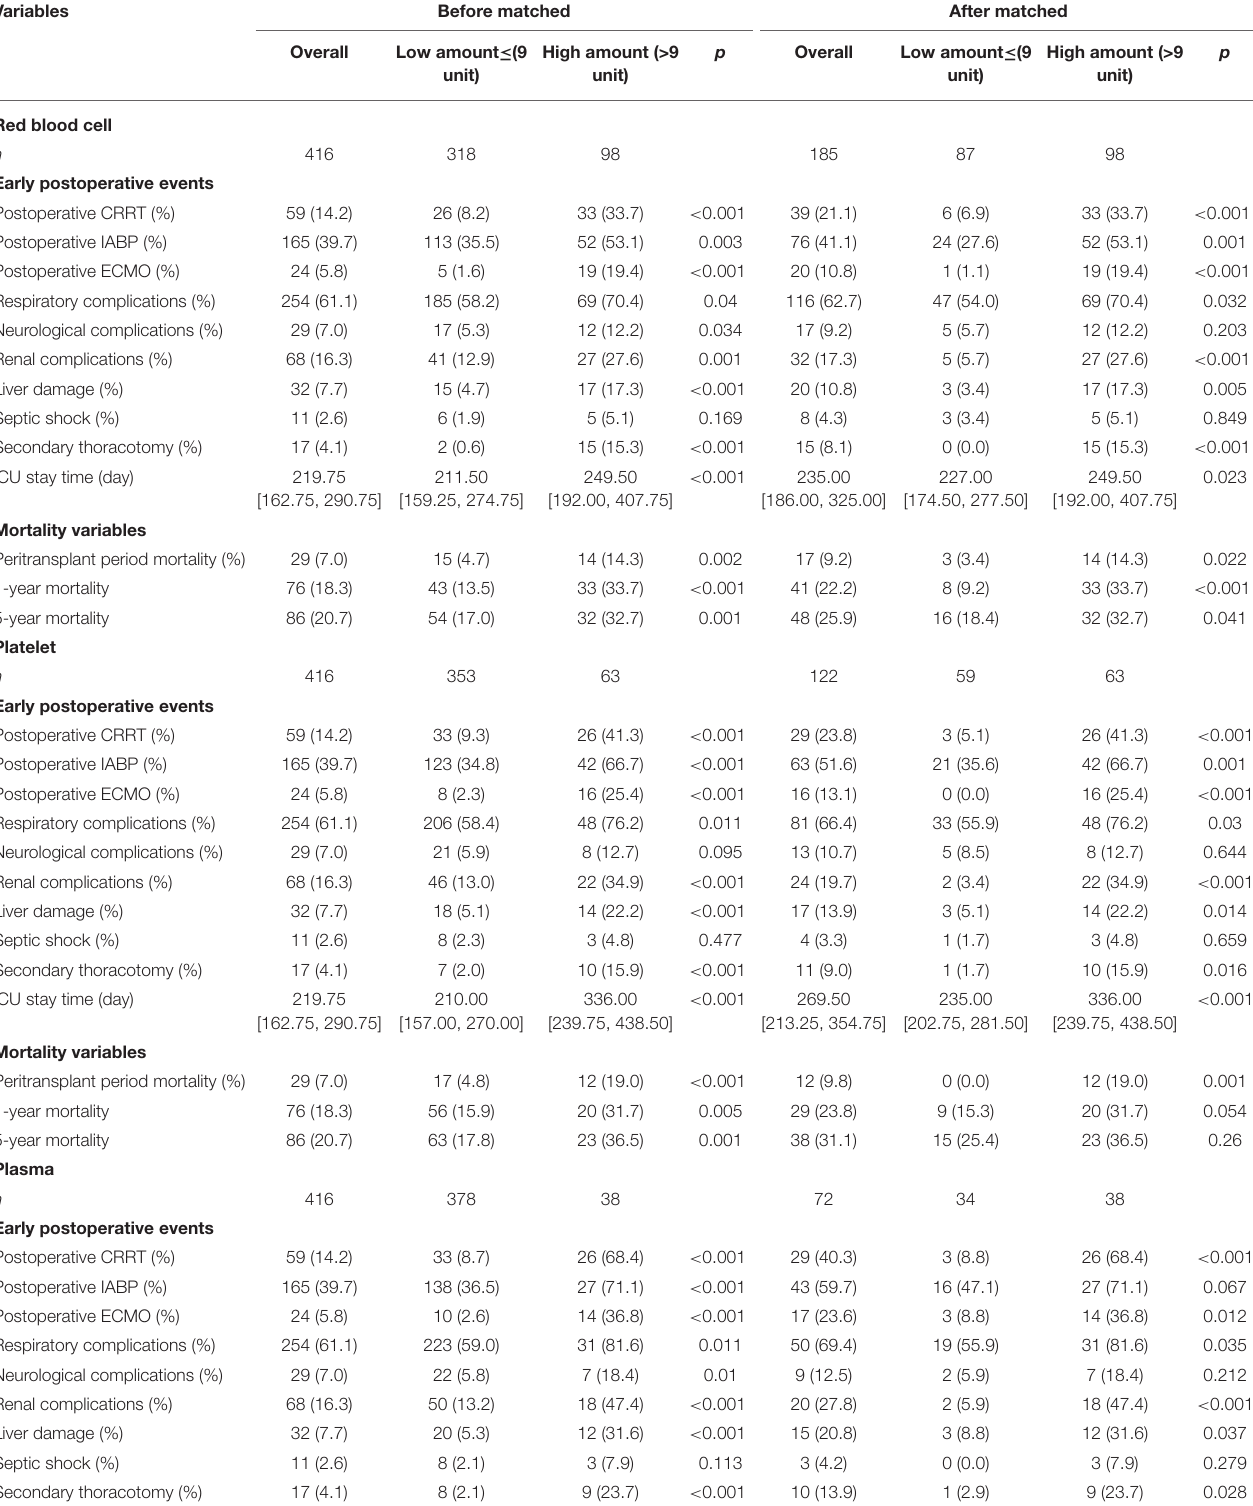
TABLE 2 | Postoperative outcome of the 416 patients in the study cohorts. Variables Before